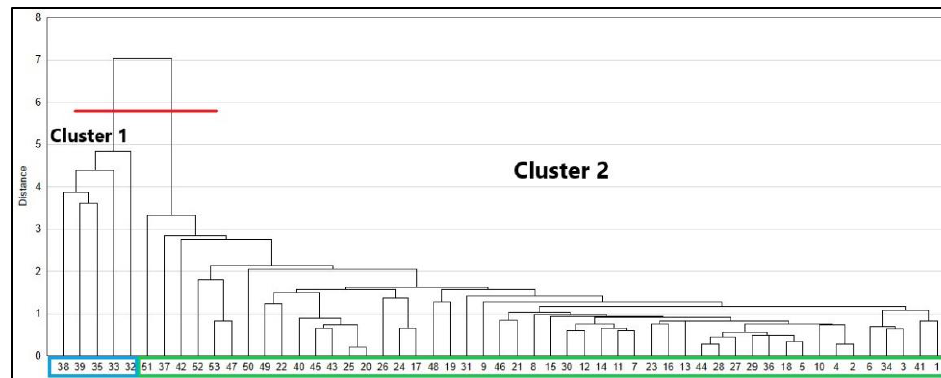
Figure 4. Dendrogram showing clusters of variables on the basis of similarity. 1–53—numbers of samples according to Table 1.